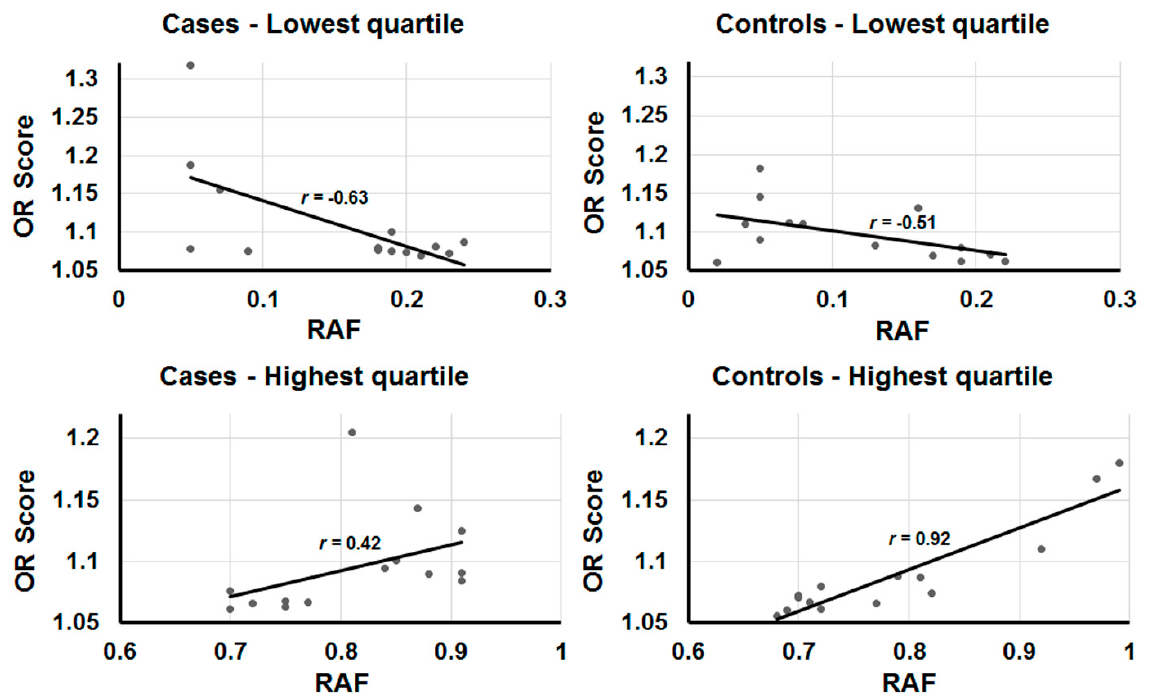
Figure 2. Regression analyses comparing RAF with OR score. Data from the highest and lowest quartiles were evaluated by standard regression analysis for relationships between their allele frequencies and adjusted OR scores. The plots show the lowest and highest quartiles of data points from SNPs that occur more frequently in cases than controls and vice versa (as labeled). The trend lines are included along with the correlation coefficient, r .